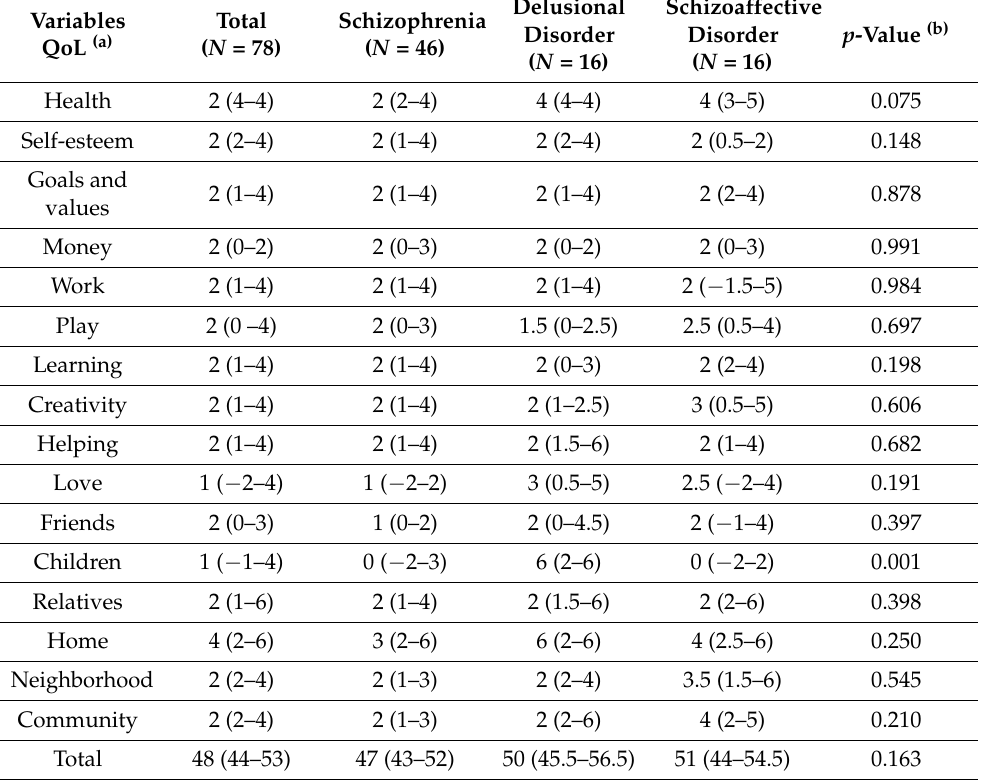
Table 4. Quality of life characteristics of the patients with psychotic-spectrum